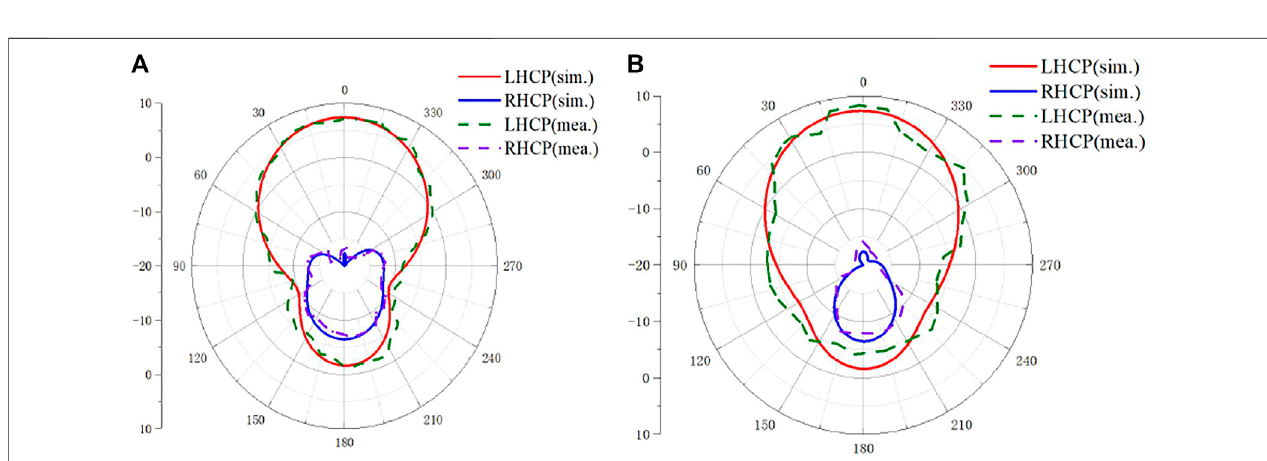
FIGURE 13 | Comparison of simulated and measured radiation patterns at 5.8 GHz: (A) xoz-plane. (B) yoz-plane.